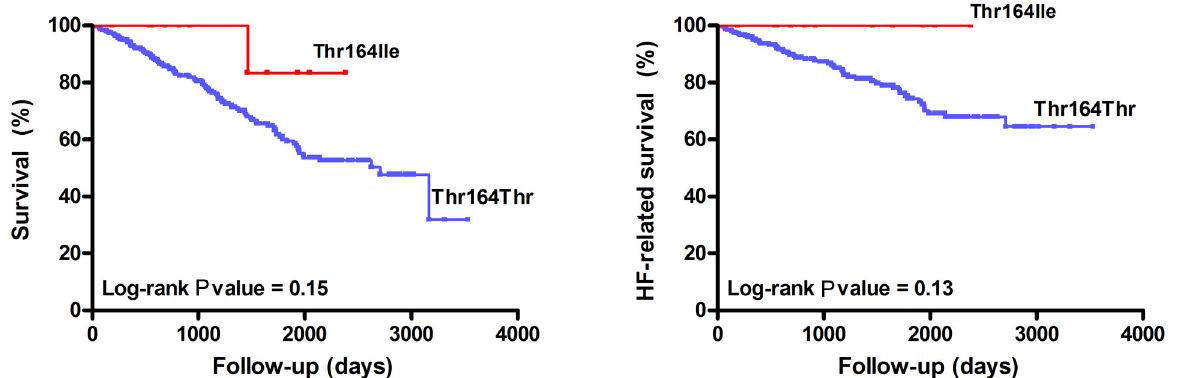
Figure 1. Kaplan-Meier survival curves as a function of the Thr164Ile genotype for all-cause mortality (N = 315, left) and heart failure (HF)-related mortality (N = 315, right).